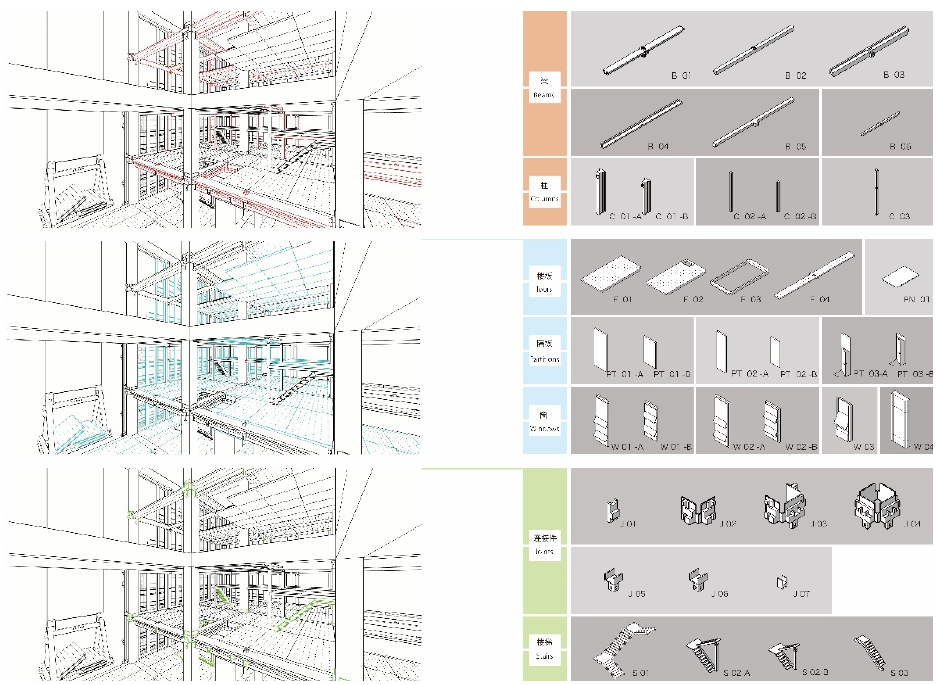
Figure 16. Schematic diagram for the adaptive structure system and architectural space module (Source: author).